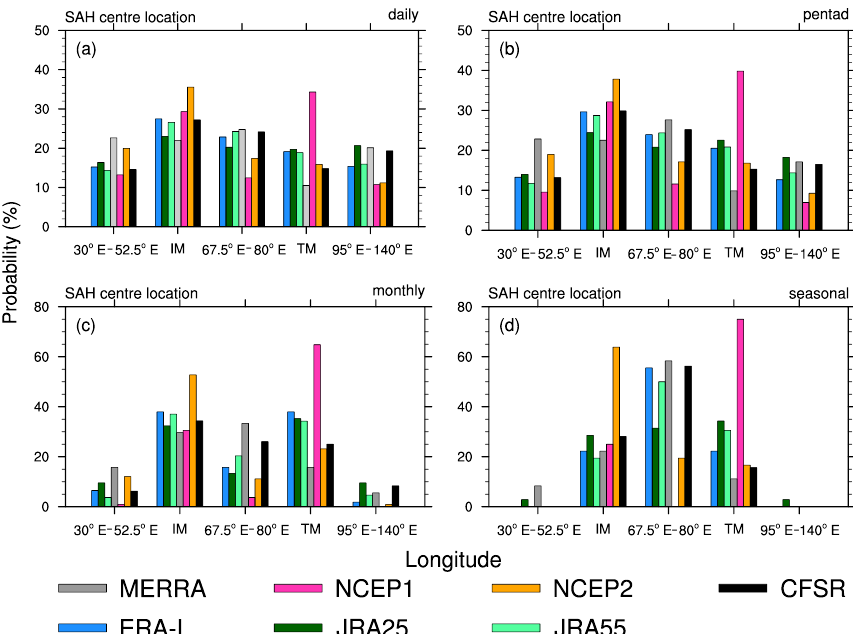
Figure 2. Overview of the probability distributions of the SAH’s longitudinal location at 100hPa based on (a) daily , (b) pentad, (c) monthly and (d) seasonal data during June to August 1979–2014 (1979–2010 for CFSR and 1979–2013 for JRA-25). The IM and TM regions comprise the longitudes 55–65 and 82.5–92.5 ◦ E respectively.